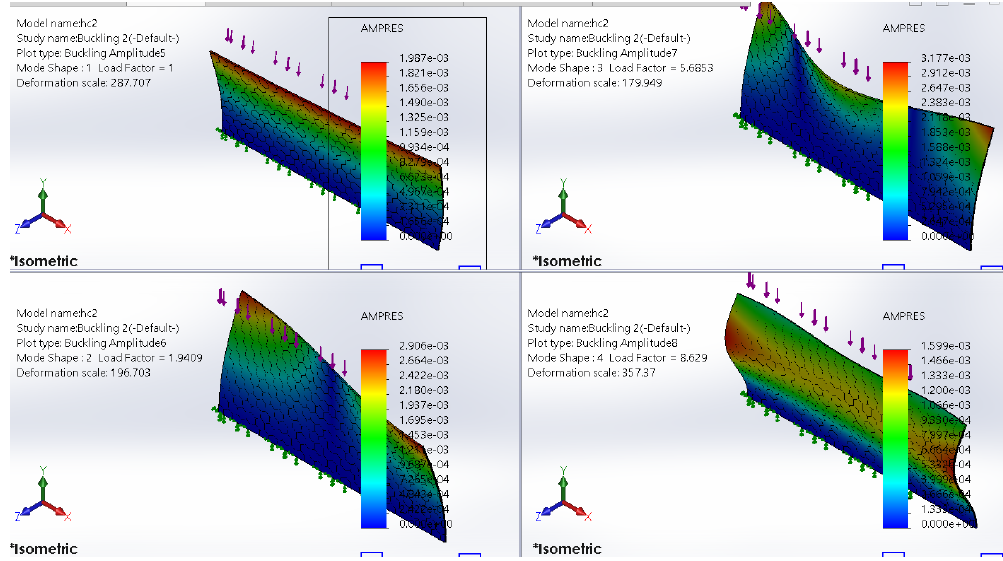
Figure 33: Buckling characteristics of the general